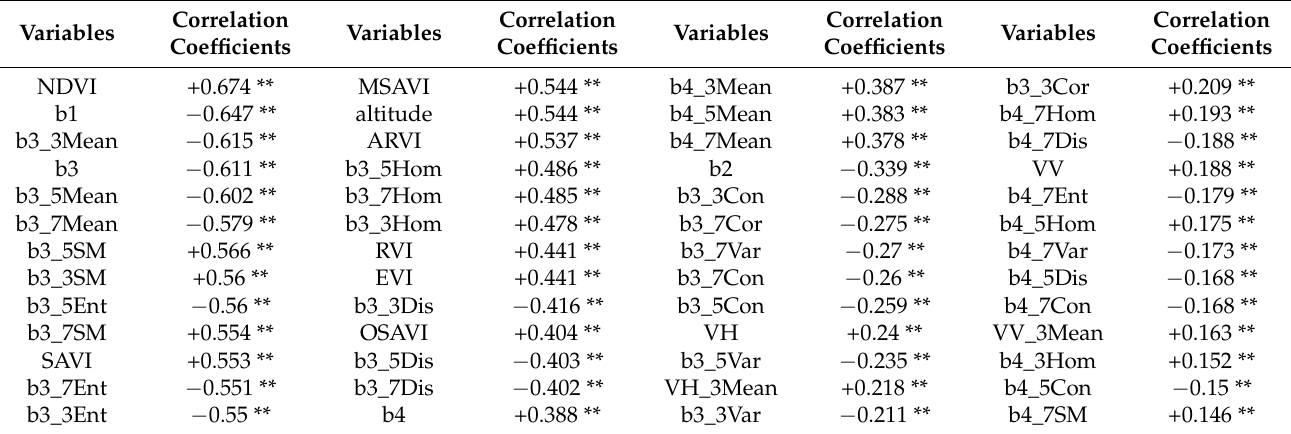
Table 4. Variables significantly associated with forest aboveground biomass.